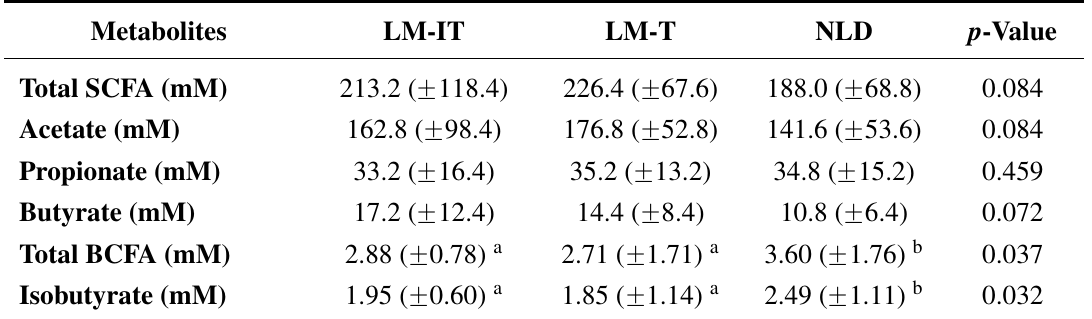
and NLD (mean ± SD). and NLD (mean ˘